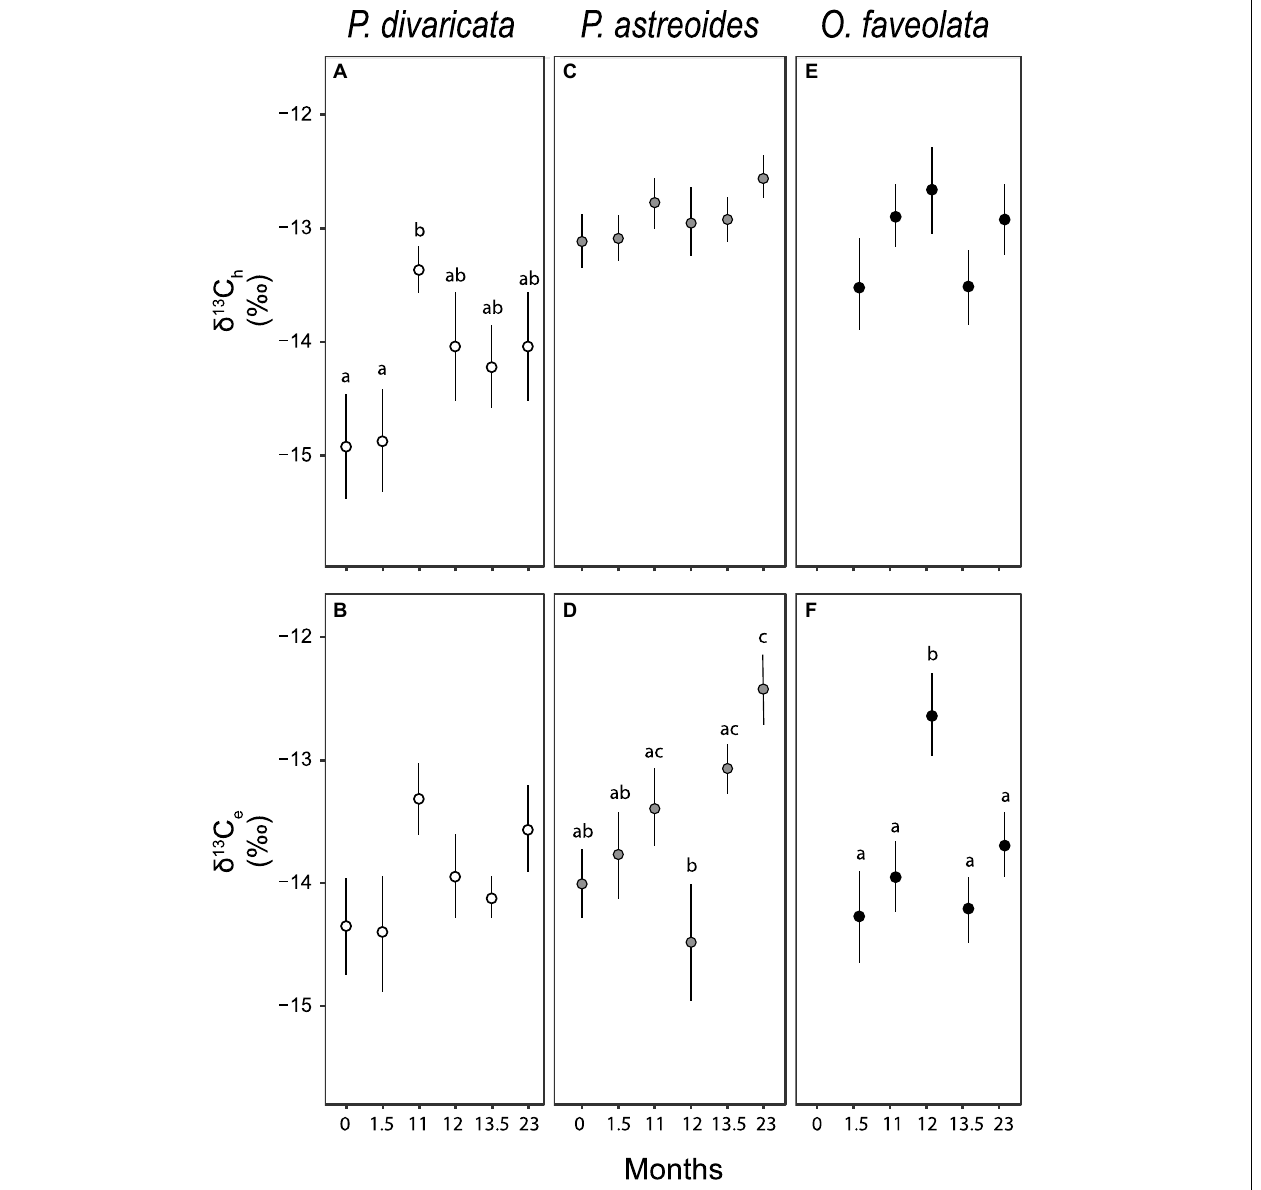
FIGURE 5 | Average ( ± 1 SE) stable carbon isotopic values of (A,C,E) the animal host ( δ 13 C h ) and (B,D,F) endosymbiont ( δ 13 C e ) fractions of Porites divaricata (white), Porites astreoides (gray), and Orbicella faveolata (black) at each time point (0 month = July 2009, 1.5 months = September 2009, 11 months = June 2010, 12 months = July 2010, 13.5 months = September 2010, and 23 months = June 2010). Sample sizes range from 5 to 9 for each average. All Kruskal-Wallis, ANOVA and Tukey post hoc results in Supplementary Table 6